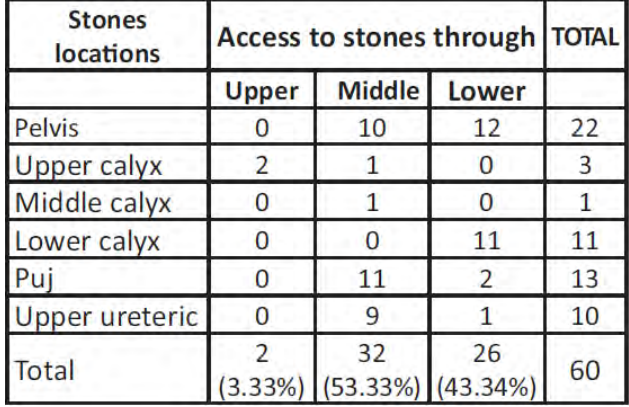
Table 3. Patients distribution depending on stone location and types of access